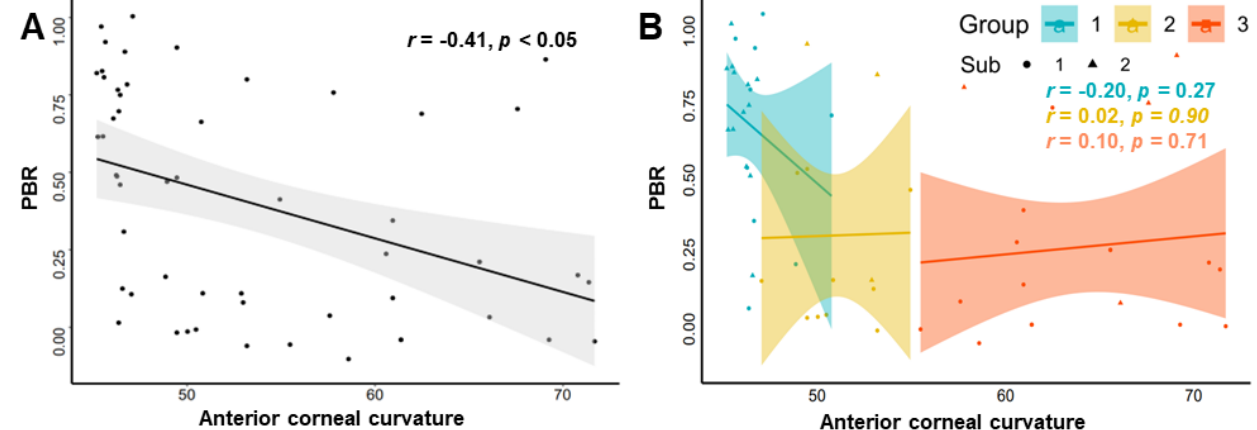
Figure 2. Partial correlogram of LLT and anterior corneal curvature. ( A ) Correlation of the overall KC patients. ( B ) Correlation of the KC patients with different severity.